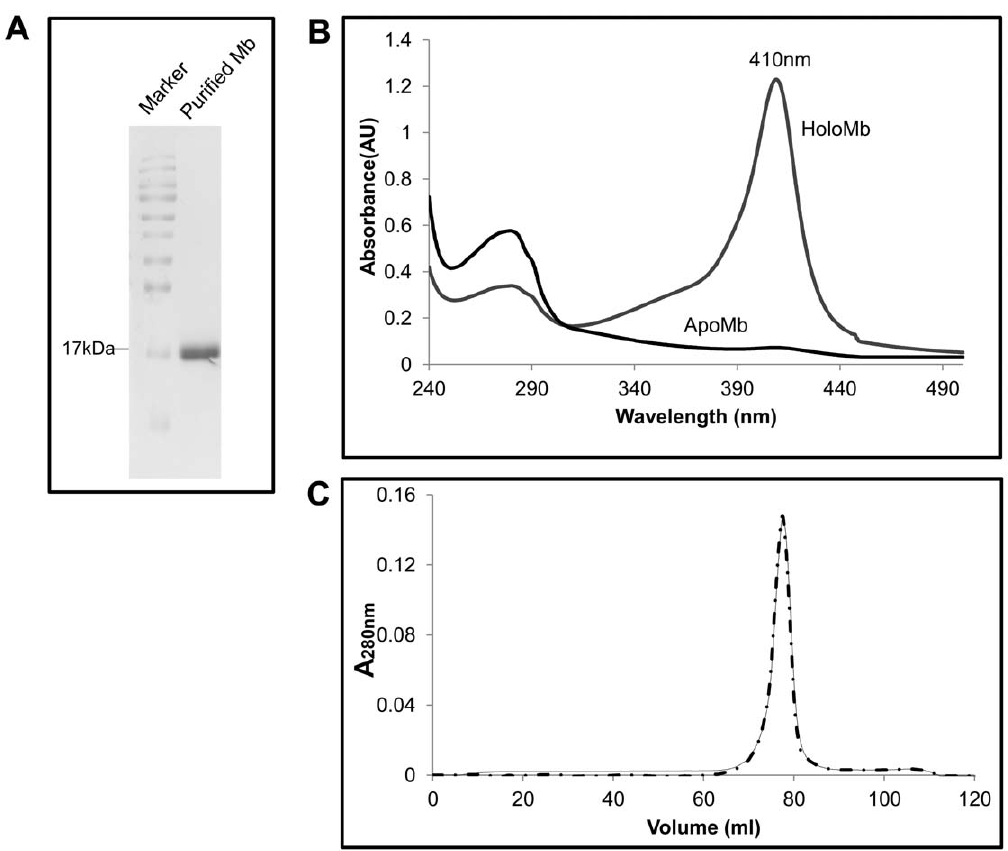
Figure 1. Purification and characterization of holo and apo myoglobin (Mb). (A) Mb was purified by cation exchange chromatography and was adjudged to be pure by SDS-PAGE analysis. (B) UV-visible spectrum of the holo and apoMb were recorded from 500 nm to 240 nm. A distinct Soret peak (410 nm) was observed in the holo form the intensity of which was reduced to about 95% in the apoMb indicating successful removal of heme. (C) Quaternary structure of apoMb was assessed by gel permeation chromatography. ApoMb (dash line) eluted at the same retention volume as the holo protein (solid line) demonstrating similarity in the protein fold.